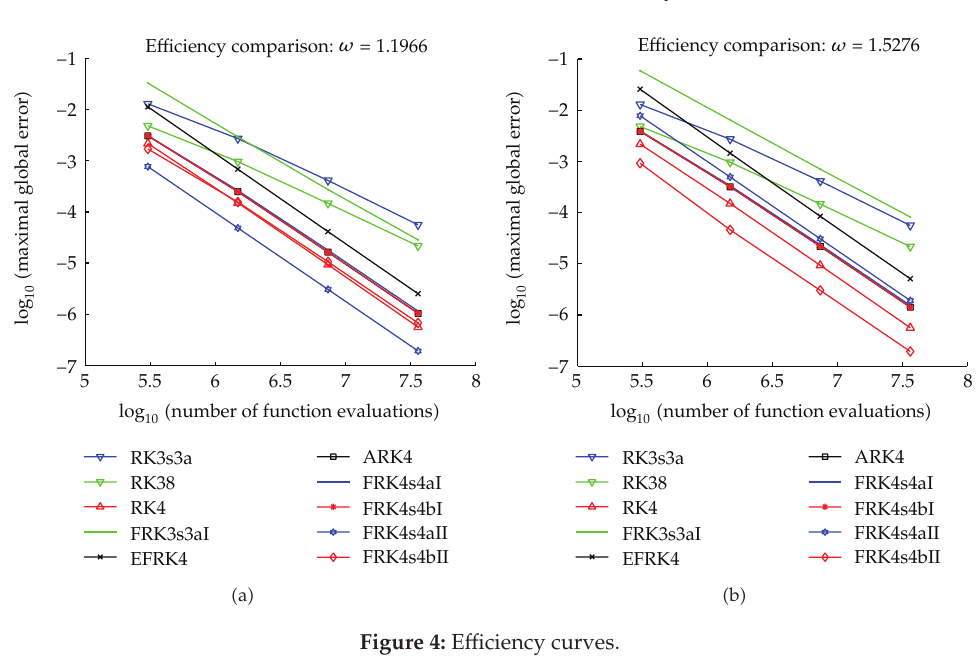
Figure 4: E ffi ciency